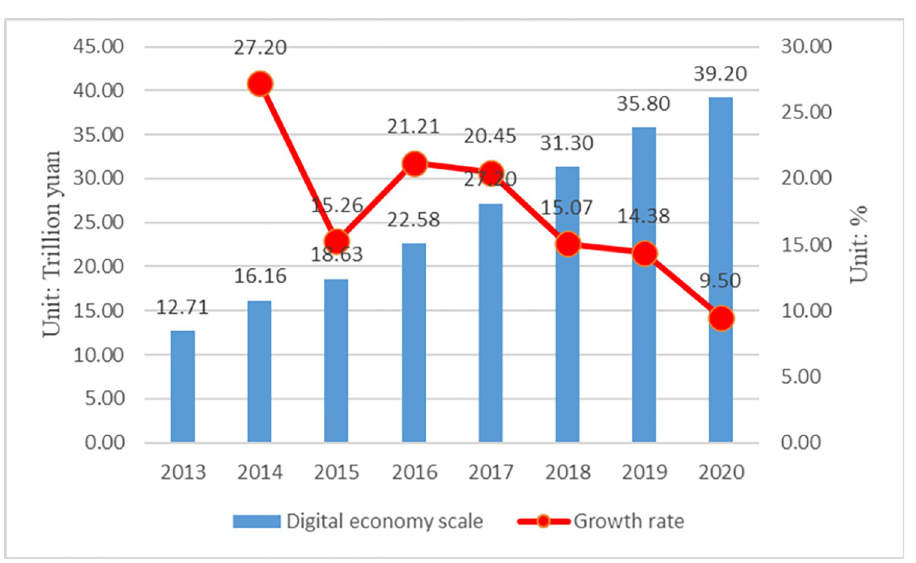
Fig 1. Scale of the digital economy and its changes in China.